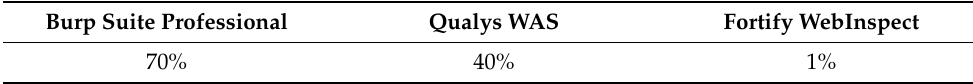
Table 4. Coverage percentage for commercial